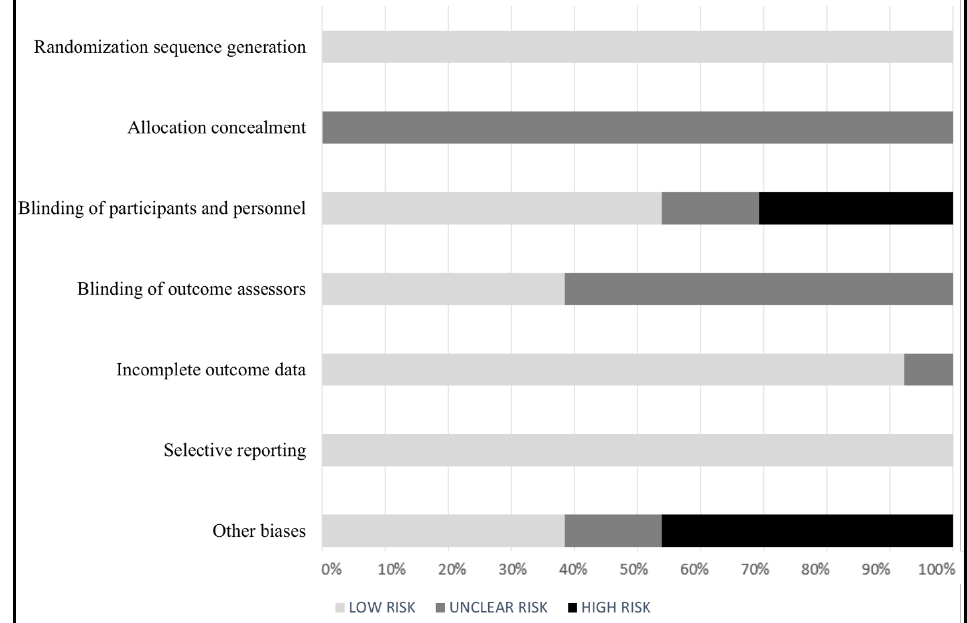
Figure 2. Quality assessment of included studies according to Cochrane risk of bias tool.